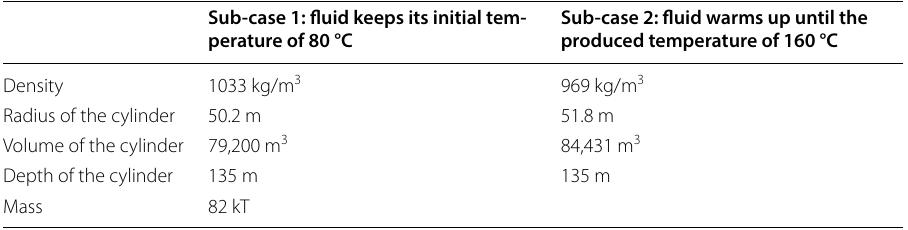
We consider the real injected